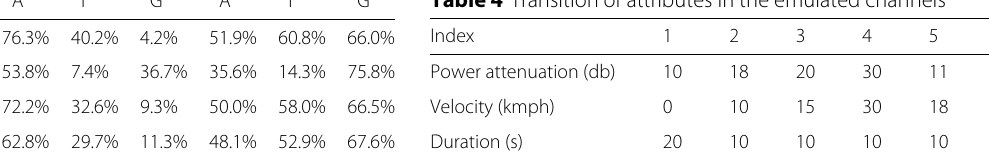
Table 3 Classification-based context-aware performance: (A)ccuracy is percentage of time classification choosing ideal rate, (I)mprovement is its throughput gain over a SNR-only method, and (G)ap is its throughput percentage from the maximum achievable WARP Ubiquiti XR2 Missing attributes